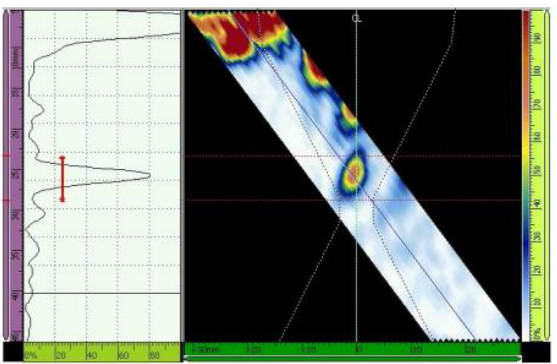
Figure 15. Echo (maximized to 80% of the screen height) from the third hole. Scanning angle of 48 ◦ , 16 active elements. Primary gain = 40.1 16 active elements. Primary gain = 40.1 dB.